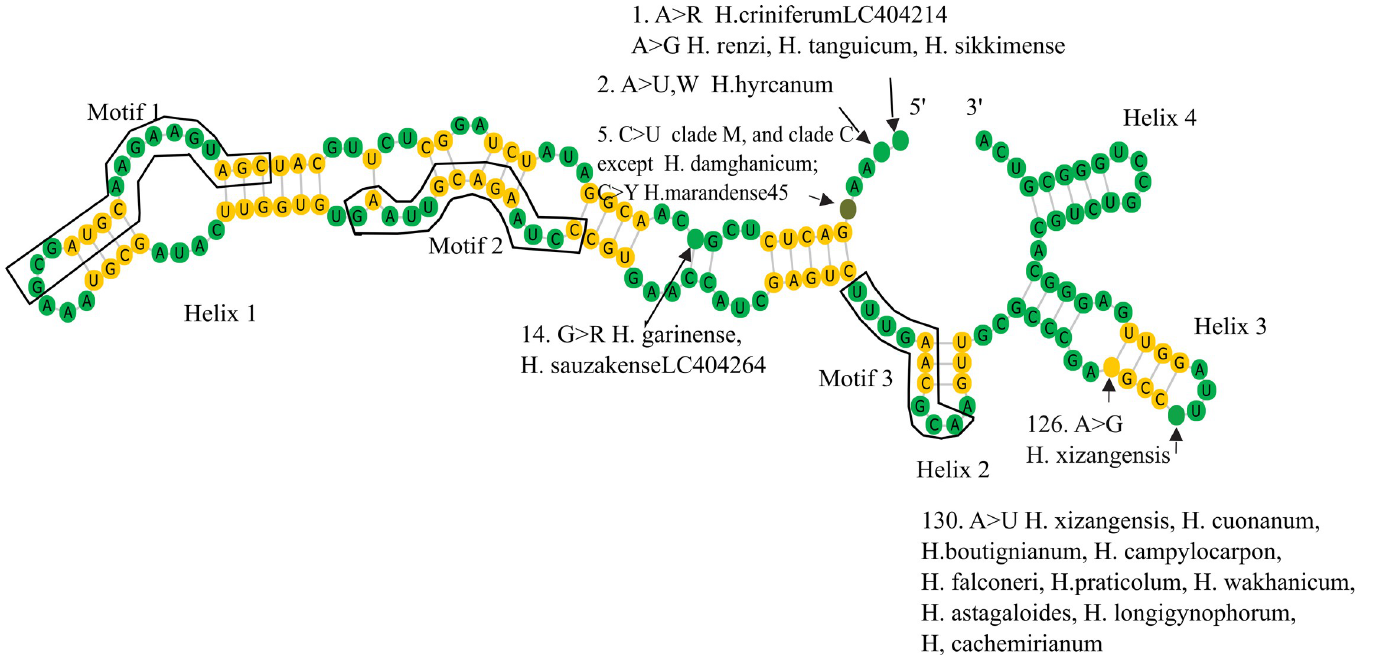
Fig 4. Olsen layout of 5.8S region 100% conserved consensus secondary